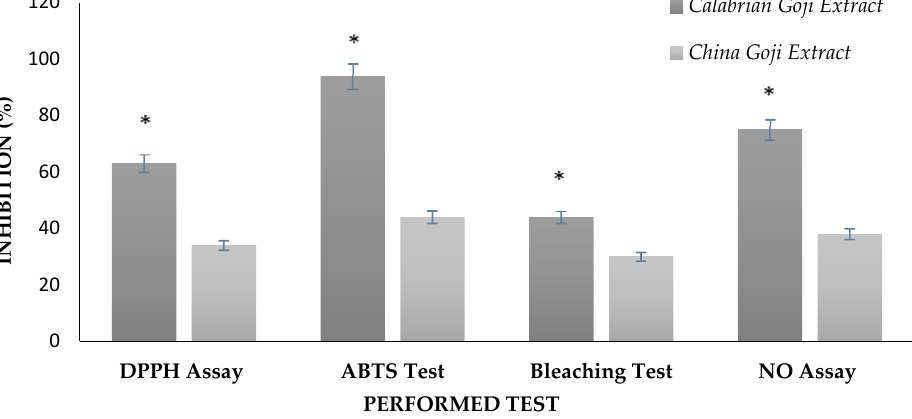
Figure 1. Antioxidant and anti-inflammatory activities of ( (cid:4) ) Calabrian and ( (cid:4) ) Chinese Goji extracts (0.15 mg/mL) in terms of DPPH, ABTS, lipid peroxidation and NO inhibition expressed as percentage. Values are the mean ± SD (standard deviation). Significance was defined as * p < 0.05.